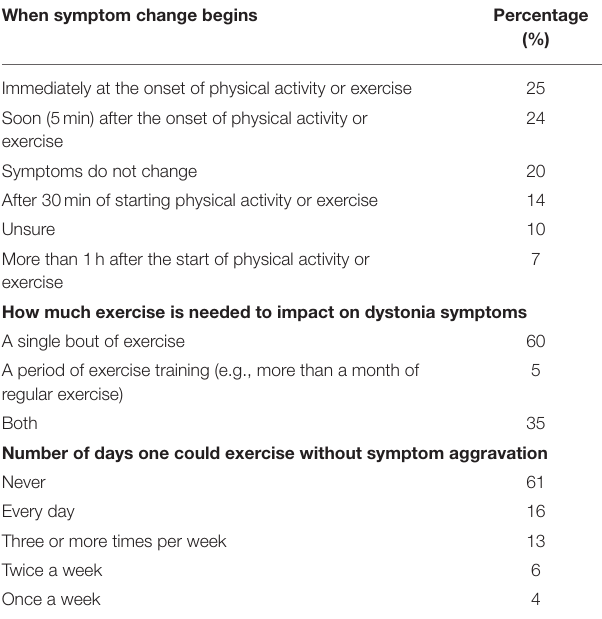
TABLE 5 | Impact of exercise on dystonia